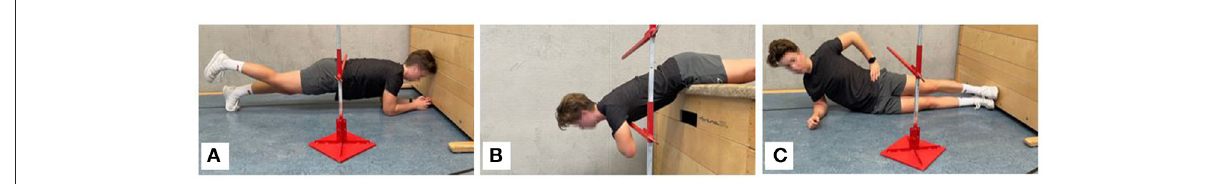
FIGURE1 Participant performing the (A) ventral, (B) dorsal, and (C) lateral (right side) chain of the Bourban